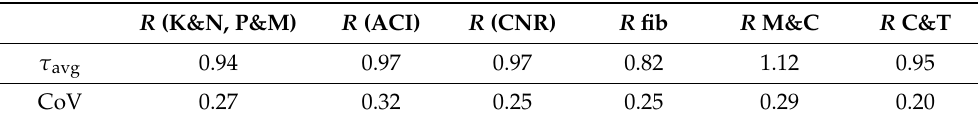
Table 1. Evaluation of combined results of Data Set 1 and Data Set 2 using the Colajanni et al. model with different R